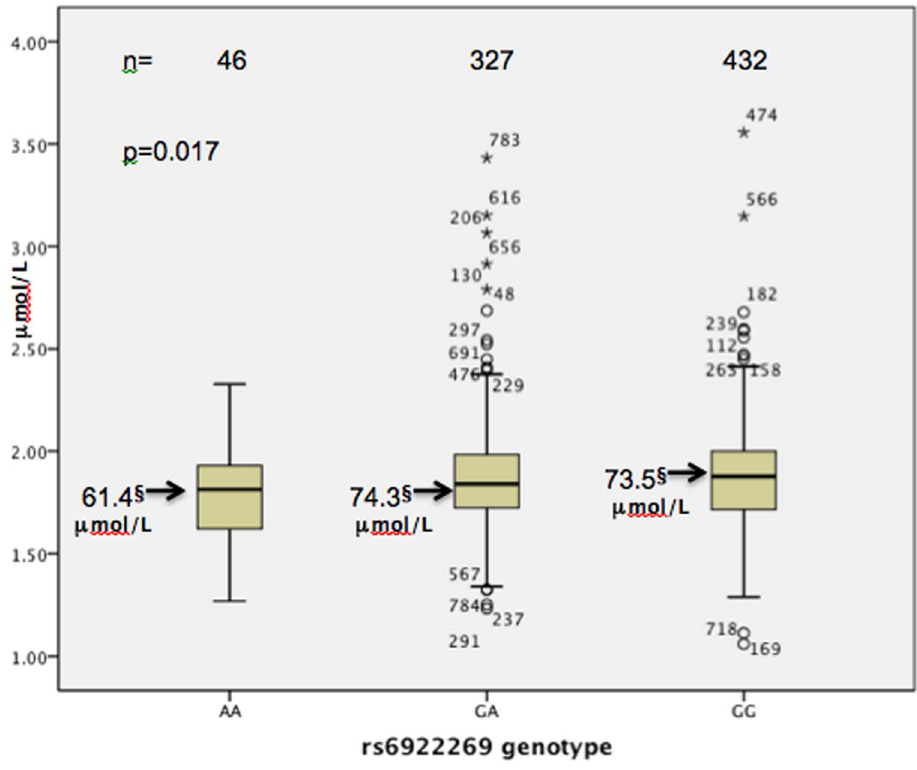
Figure 1. A boxplot comparison of log-transformed plasma active vitamin B12 levels at baseline post-admssion in rs6922269 genotype groups. The p-value compares data adjusted for age and hypertensive status. 1 Geometric means.